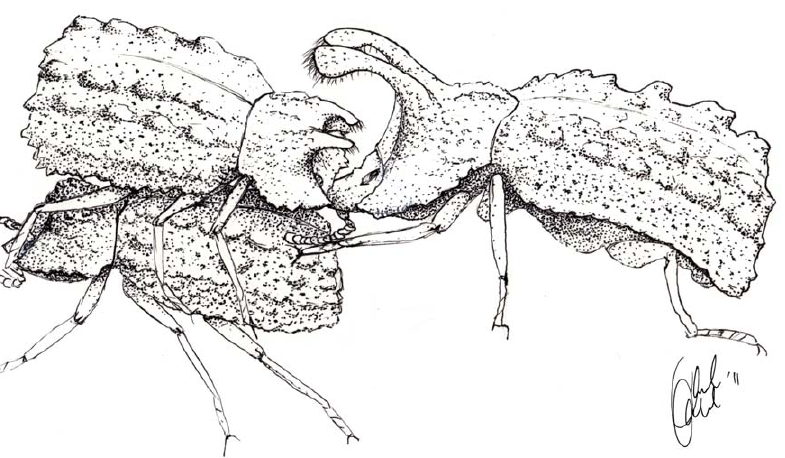
Figure 1. A small B.cornutus male exhibiting the use of the grip strength in the wild. The small male is courting the female while the large male attempts to use his clypeal horns to dislodge the courting male. While these images illustrate an attack from the front of the courting male, we have observed attacks from behind as well as perpendicularly to the defensive male (personal observation). Attacks also occur during mate guarding, when the male and female are oriented in the same direction. Illustration by Ariel Kahrl, from the supplemental